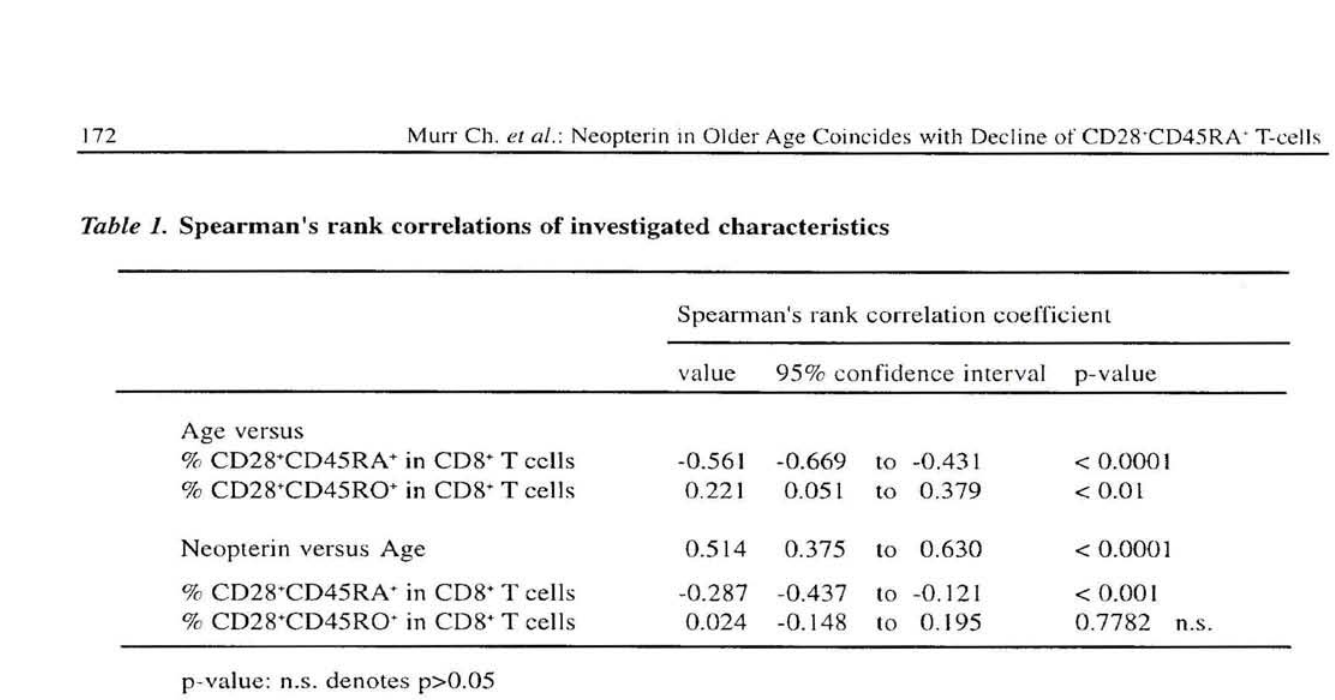
Table 1. Spearman's rank correlations of investigated characteristics